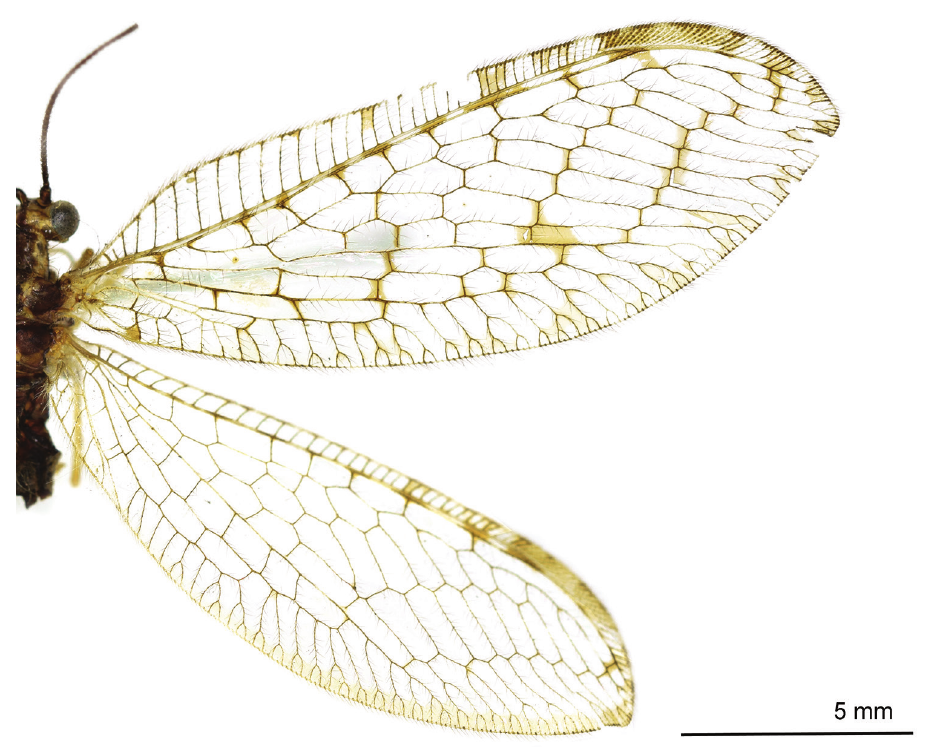
Figure 44. Wings of Heterosmylus curvagradatus Yang, 1999.